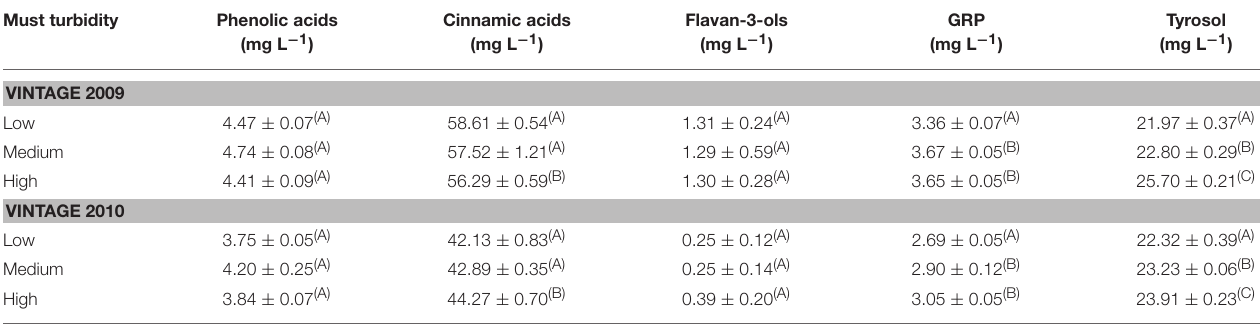
TABLE 1 | Mean concentrations with standard deviations of white wine polyphenols concentrations, regardless of closures, expressed in mg L − 1 , gathered by chemical families: phenolic acids (gallic acid, protocatechuic acid, hydroxybenzoic acid, hydroxytyrosol, salicylic acid), cinnamic acids (caffeic acid, coumaric acid, ferulic acid, coutaric acid, caftaric acid), flavan-3-ols (catechin and epicatechin), GRP (Grape Reaction Product) and tyrosol.